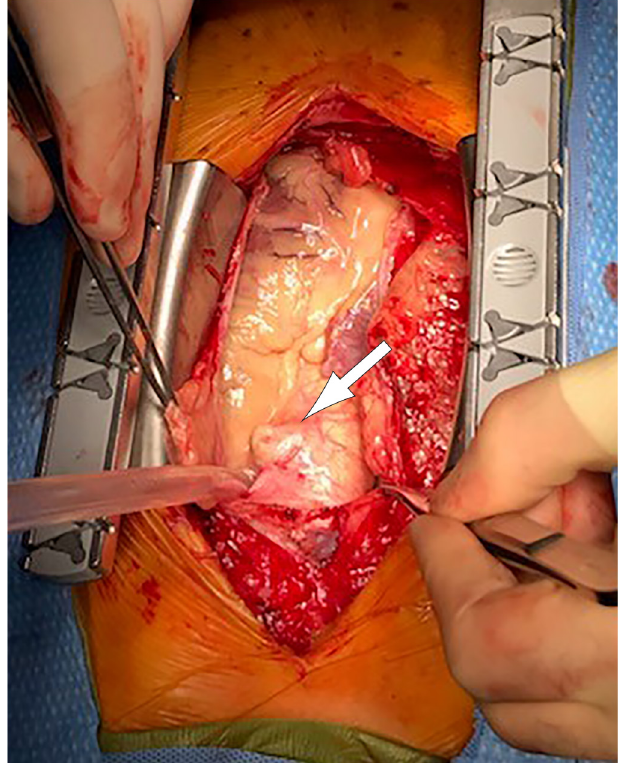
Fig. 2 - Gross intraoperative image of the ascending aorta demonstrates one of several outpouchings due to aortic ulceration with intramural hematoma. Arrow indicates the outpouching.